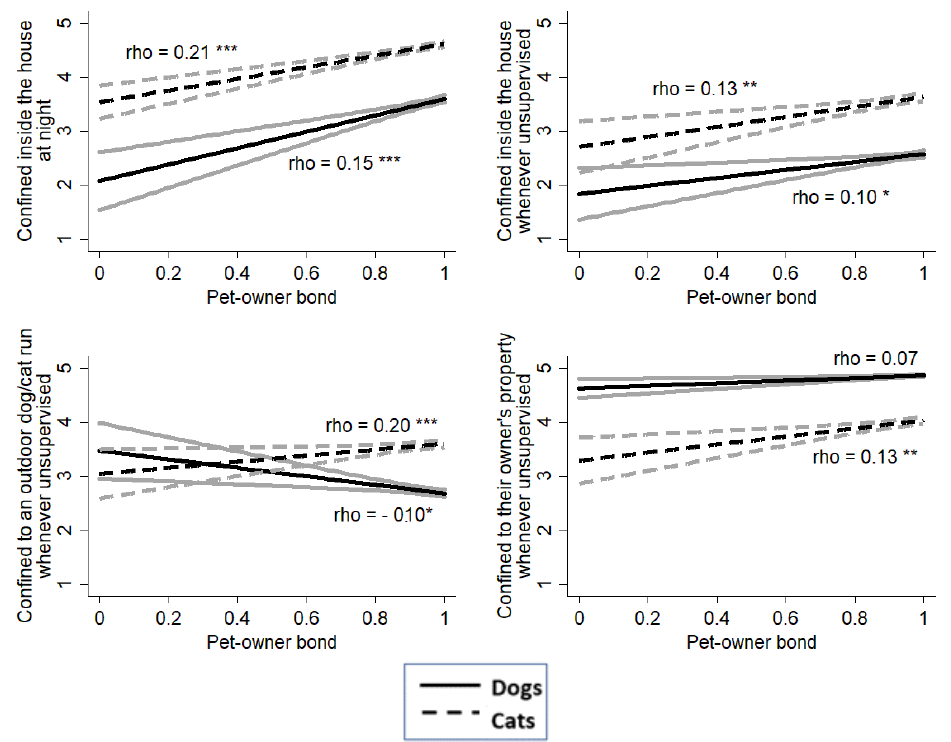
Figure A4. Bivariate associations between pet – owner bond and individual items on pet confinement, separately for dogs (in 1291 dog owners) and cats (in 1146 cat owners); Spearman’s correlation coefficients (rho) are presented for each line with significance level denoted by the asterisk (* p < 0.05, ** p < 0.01, *** p < 0.001). Table A2. State/territory cat containment legislation.